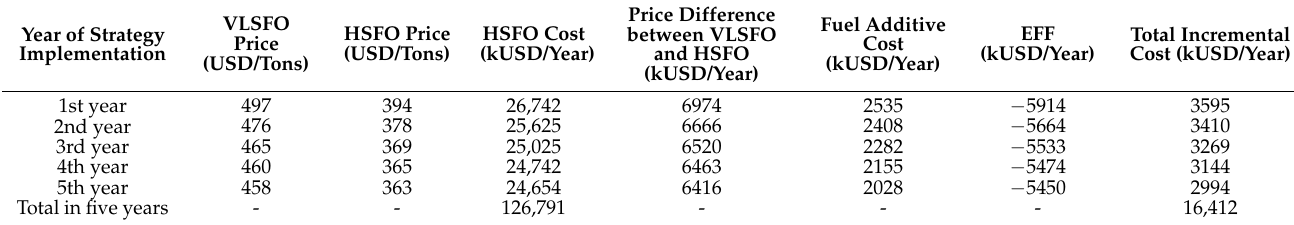
Table 11. Various incremental costs of the VLSFO strategy.